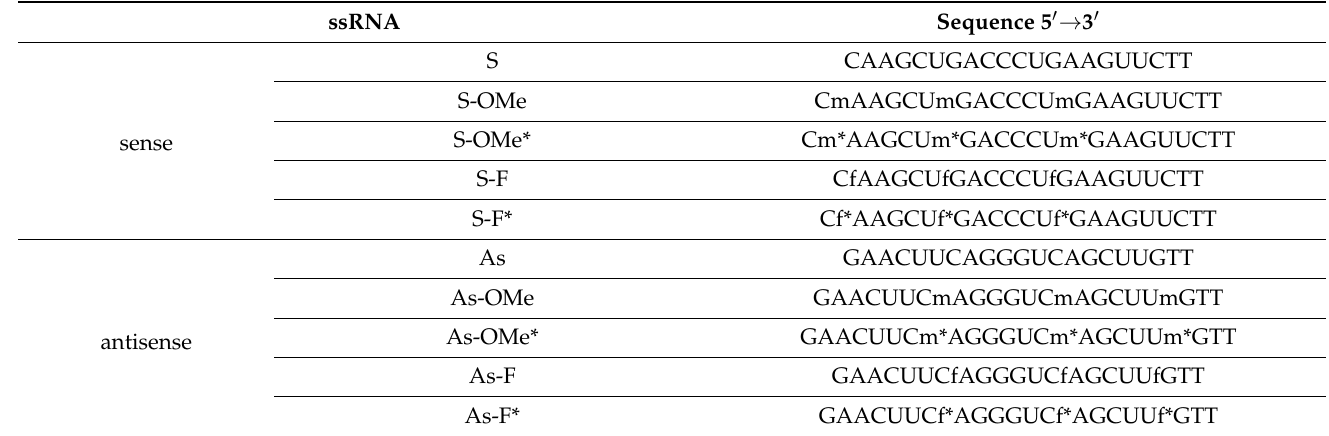
Table 1. Sequences of single-stranded oligoribonucleotides